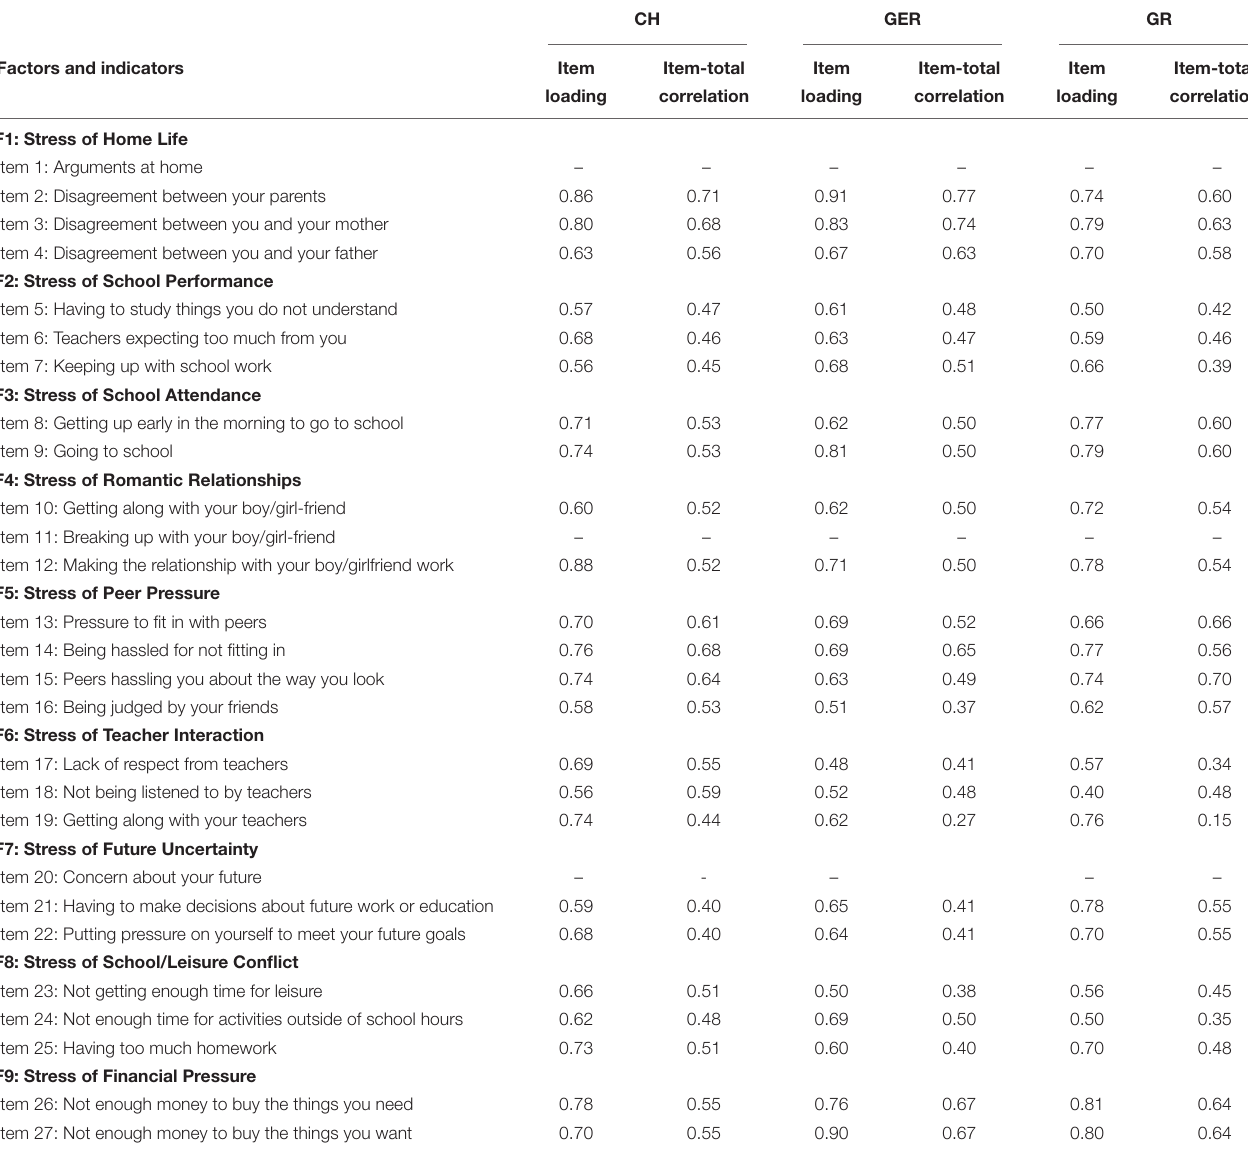
TABLE 2 | 9-factor structure of the adolescent stress questionnaire-shortened version (ASQ-S); standardized loadings and item-total correlations. CH GER GR Factors and indicators Item Item-total Item Item-total Item Item-total loading correlation loading correlation loading